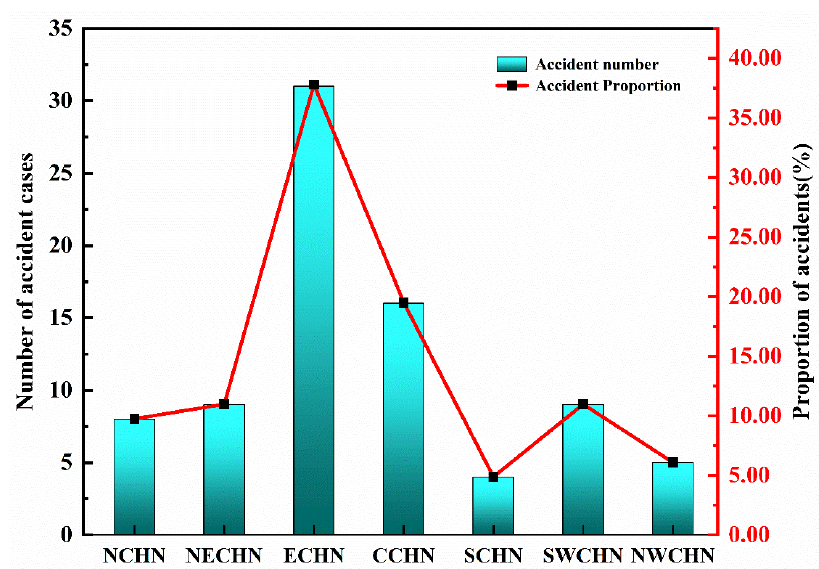
Figure 6. Accident number and proportion by seven administrative divisions.